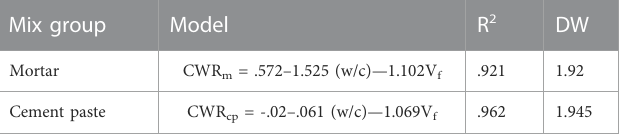
TABLE 10 Proposed equation of crack width of mortar and cement paste with PP and w/c ranging from .3 to .5 in the eccentric-ring test.